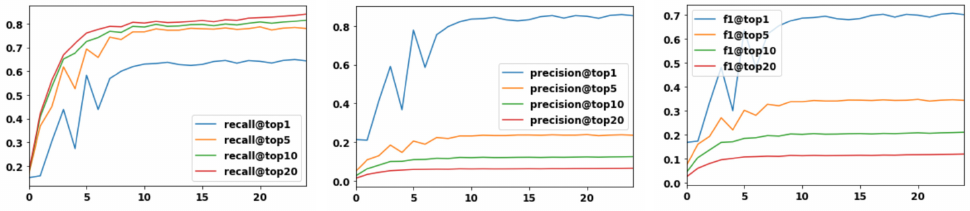
Figure 6. Recall@k, precision@k, and F1@k through 25 training epochs of the proposed M-CRBMs that take three types of extra information into account.